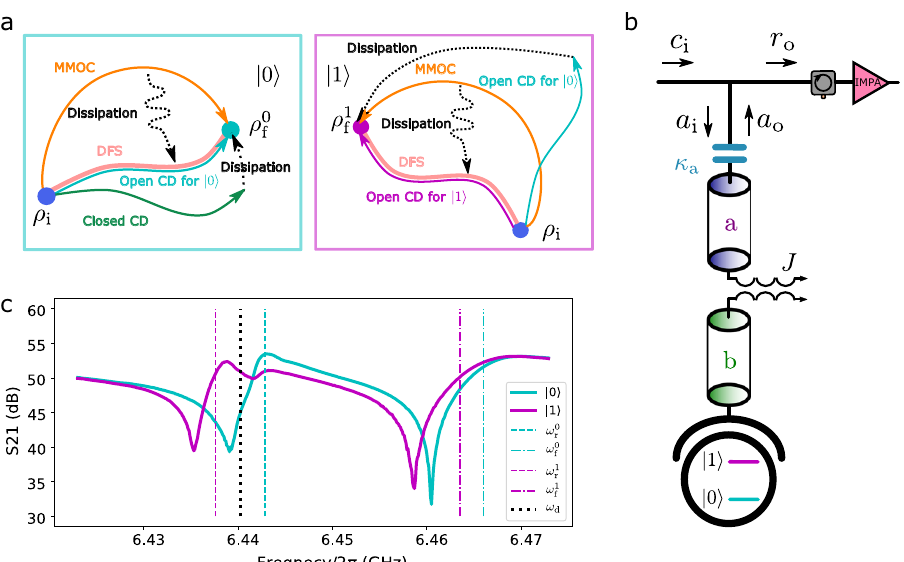
Fig. 1 Experimental setup and principles of shortcut to adiabaticity (STA). a Schematic of relevant dynamics. An adiabatic protocol transfers the initial state ρ i to the fi nal state ρ 0 ; 1 along the light pink trajectories in the decoherence-free subspace (DFS), which is precise only in the in fi nite time limit. To f accelerate this adiabatic trajectory, a counterdiabatic (CD) driving can be applied to cancel non-adiabatic transitions, making the adiabatic approximation exact. Due to the effect of dissipation, CD driving for closed quantum systems has limited effectiveness, while its open system extension achieves